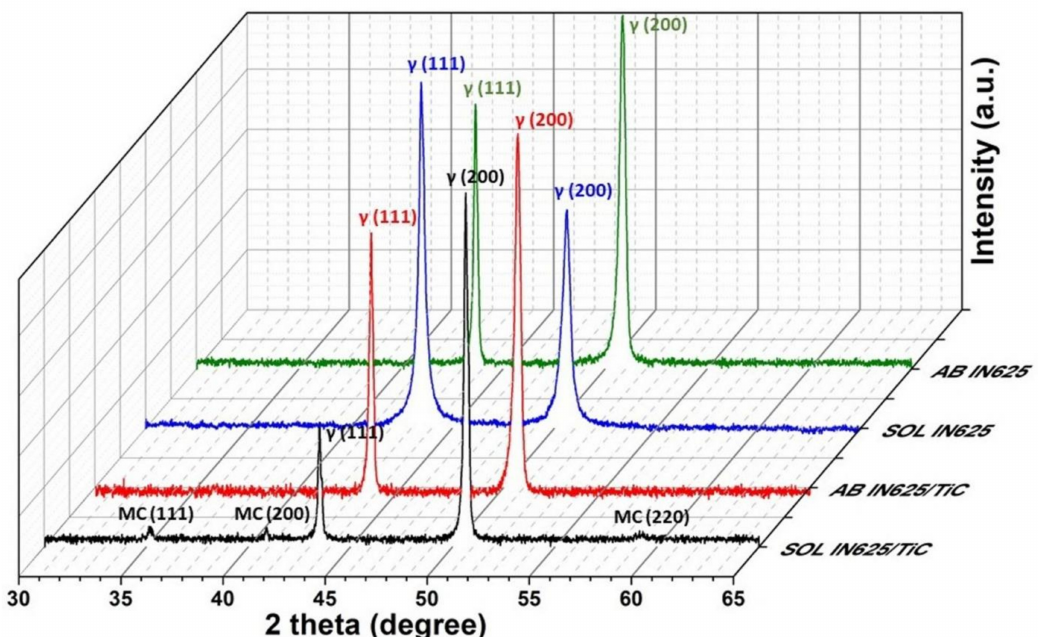
Figure 8. XRD patterns of the AB and SOL IN625 and IN625/TiC samples, revealing the presence of peaks of gamma austenitic phase and MC carbides.